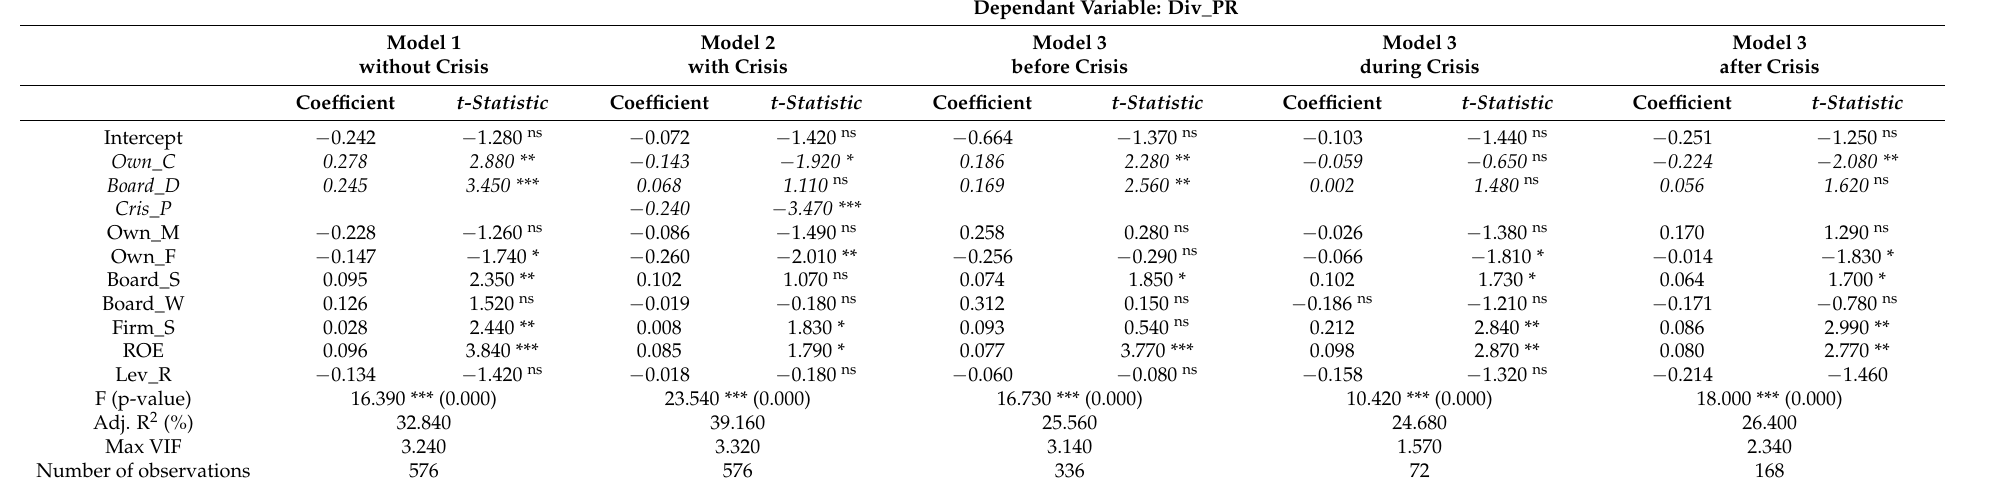
Table 4. Multivariate regression